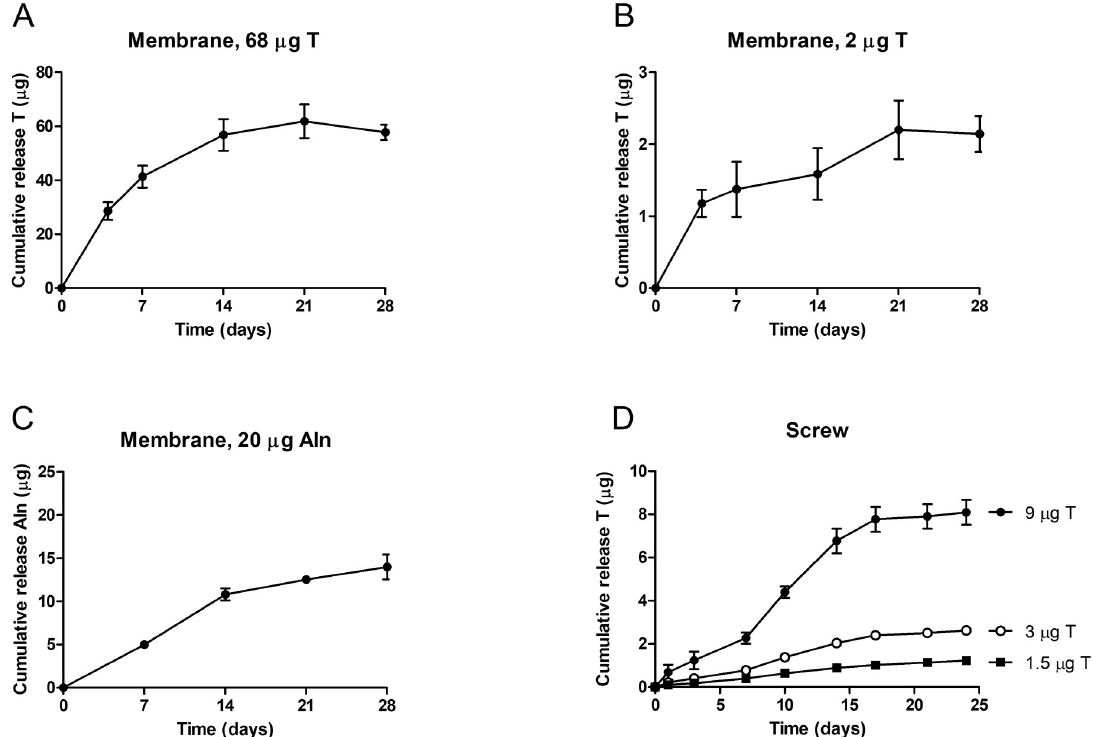
Fig 2. Cumulative in vitro release of testosterone (T) and alendronate (Aln) from coated membranes and screws. The release profile of testosterone from membranes coated with 68 μ g (A, n = 2) and 2 μ g testosterone (B, n = 2) show a sustained release of testosterone up to 21 days, while the release of alendronate continues up to 28 days (C, n = 4). The release profile of testosterone from screws coated with 1.5, 3 and 9 μ g testosterone and 2 μ g alendronate (D, n = 2) show a sustained release of testosterone up to 24